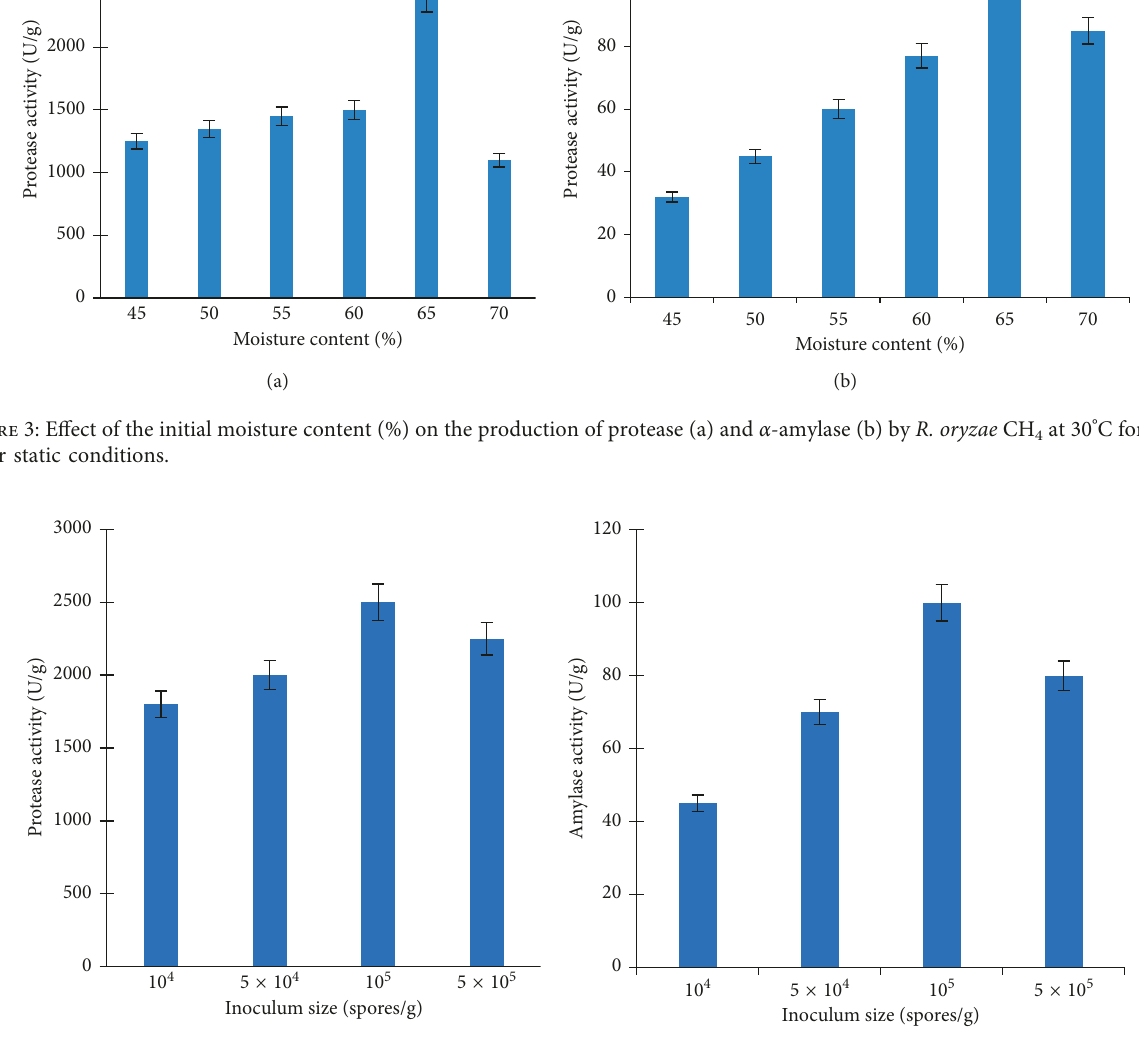
Figure 4: Effect of inoculum size on protease activity (a) and amylase activity (b).